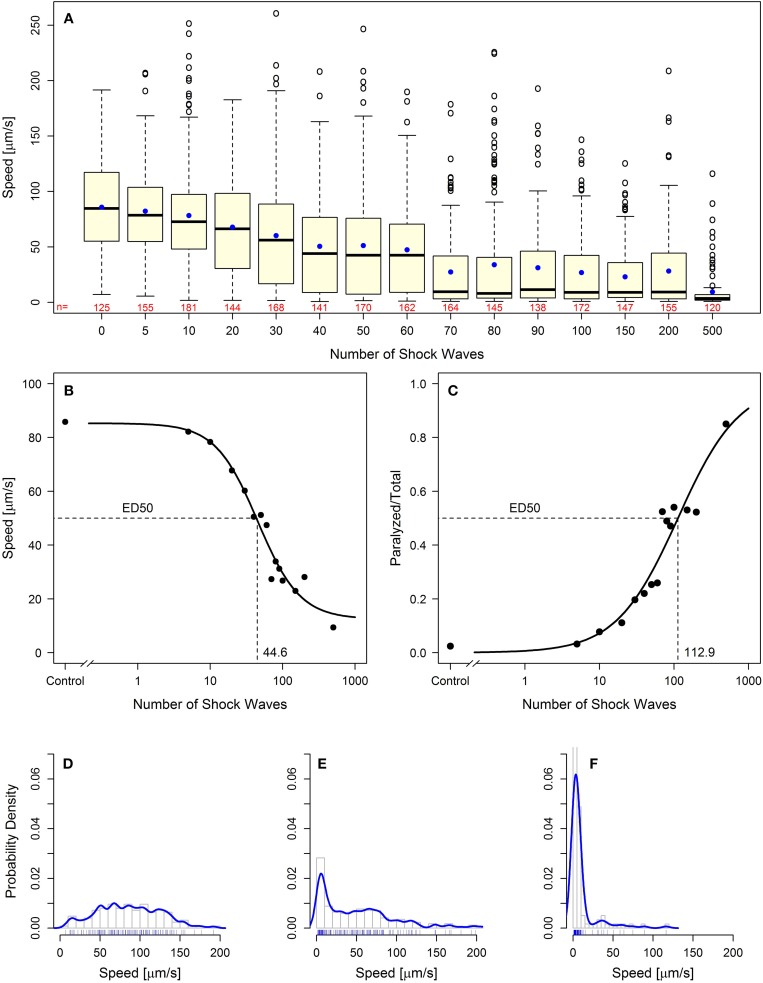
Behavioral loss-of-function of C. elegans worms following shock wave exposure. (A) Increased exposure to shock waves resulted in decreased mean speed of movement in all groups of worms exposed to at least 30 shock waves (p < 0.05). Represented as individual points, 97 positive-lying outliers were found within shock wave exposed groups of worms. Horizontal lines within the boxes represent median speeds, dots within the boxes average speeds, and box and whiskers were plotted using the Tukey method. The numbers below the boxes indicate the numbers of worms per group. (B) Worms exhibited dose-dependent response to shock wave application (ED50 = 44.6 shock waves) using the parameter “speed of movement” (calculated using the average speed of each individual worm). The dots represent average speed of the worms in each exposure groups. (C) Worms exhibited dose-dependent response to shock wave application (ED50 = 112.9 shock waves) using the parameter “relative number of worms paralyzed.” The dots represent the fraction of worms paralyzed in each exposure group. (E) Control worms showed a normal distribution of speed of movement. (E,F) Groups of worms exposed to more than five shock waves exhibited significant right-hand skew (p < 0.05). Probability density curves are shown for 50 (E) and 500 (F) shock waves, respectively.